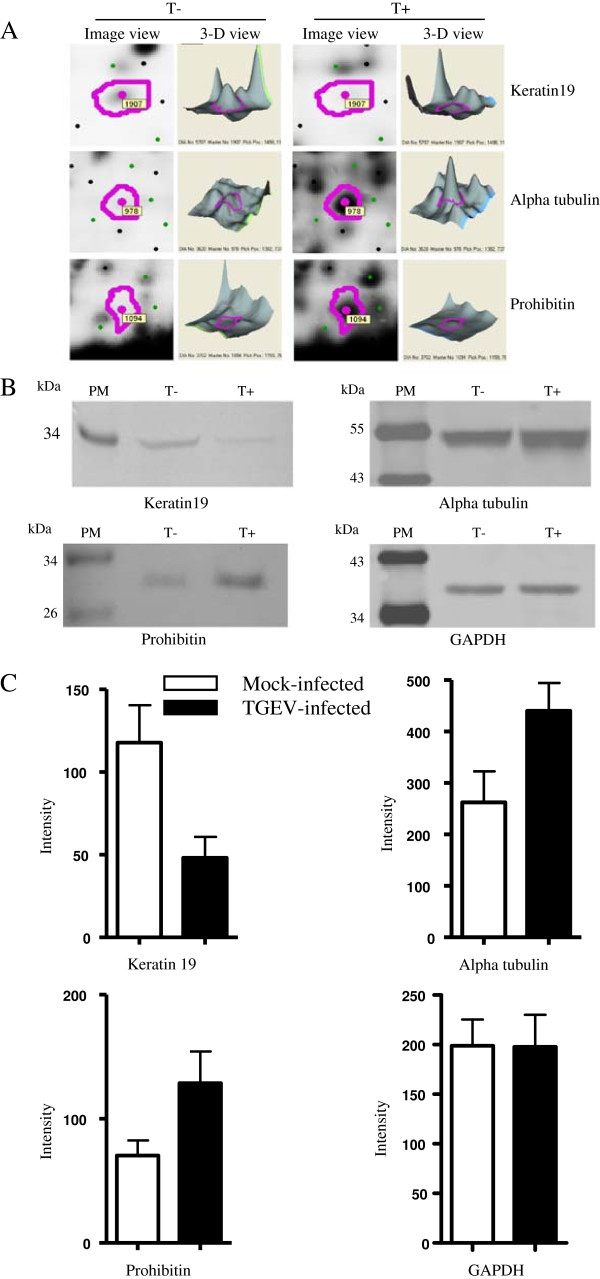
Western blot confirmation of representative proteins in TGEV-infected ST cells. Representative image of ImageQuant and DeCyder analysis of keratin19, alpha tubulin, vimentin, and prohibitin in 2D DIGE gels (A). The immunoblot analysis of keratin19, alpha tubulin, vimentin, and prohibitin in TGEV-infected and mock-infected ST cells (B). The averaged densitometric intensity of keratin19, alpha tubulin, vimentin, and prohibitin in immunoblot analysis, with GAPDH as a loading control (C). T + and T- represent TGEV-infected and mock-infected ST cells, respectively. PM, protein marker. Image view and 3-D view obtained from DeCyder.